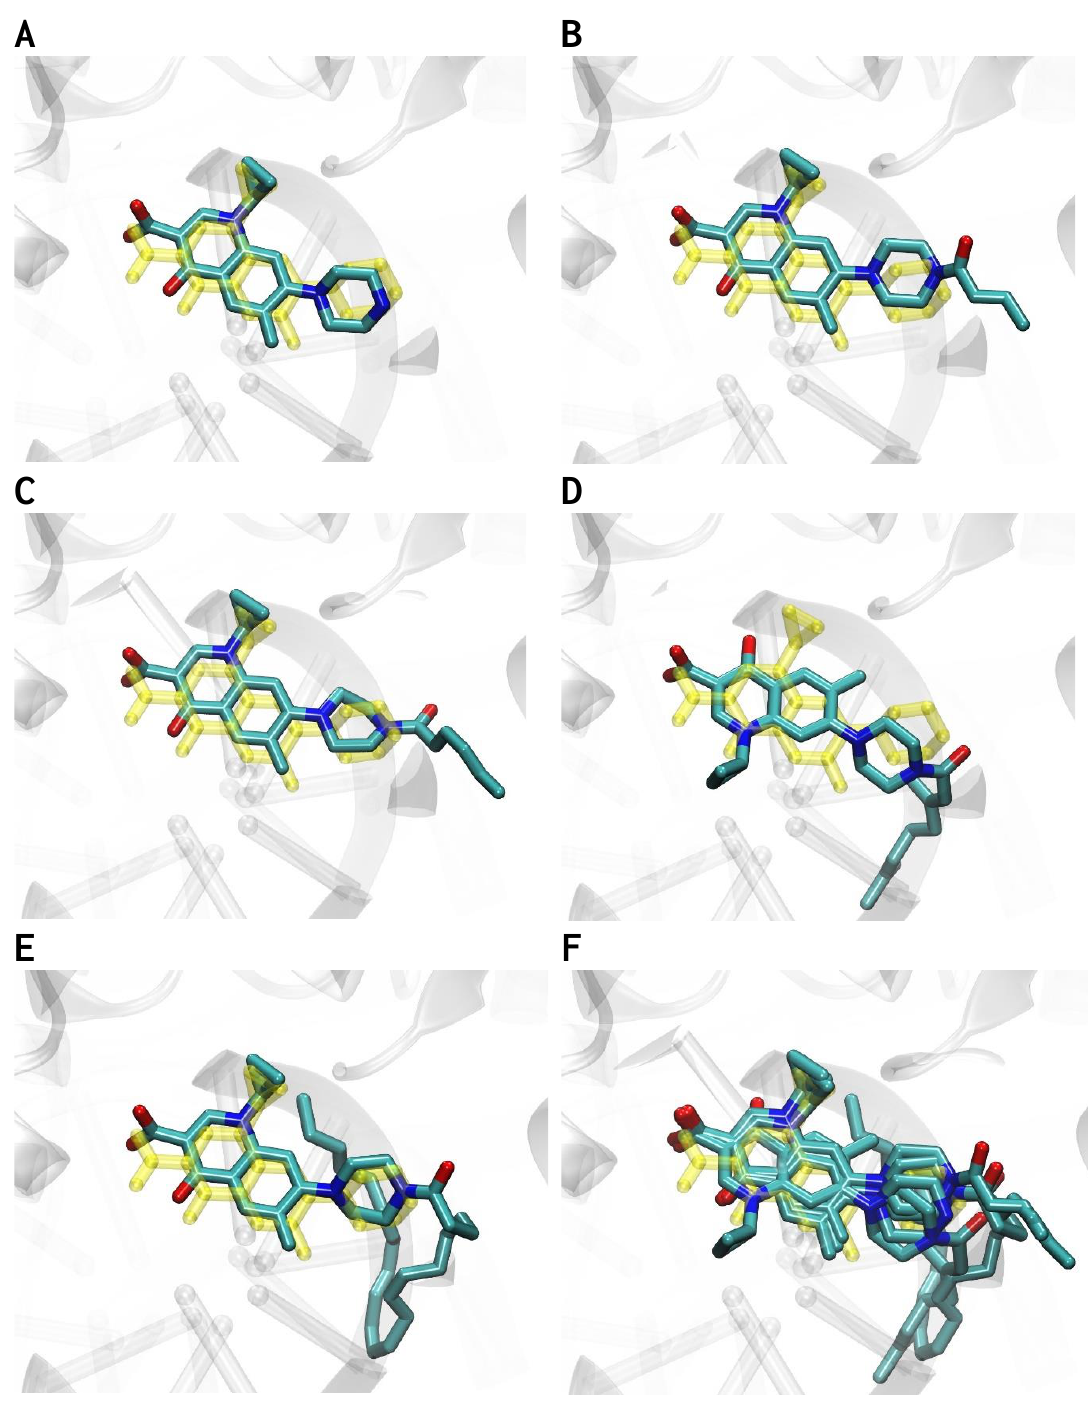
Figure 4. Binding modes of docked ligands to DNA gyrase structure (PDB ID: 5BTC [34]). Structure of bound CP and its four derivatives: 1 – 3 and 8 panels ( A – E ). Superimposition of five docked ligands is shown in panel ( F ). For comparison, the structure of CP present in the crystal structure 5BTC is shown in color yellow.